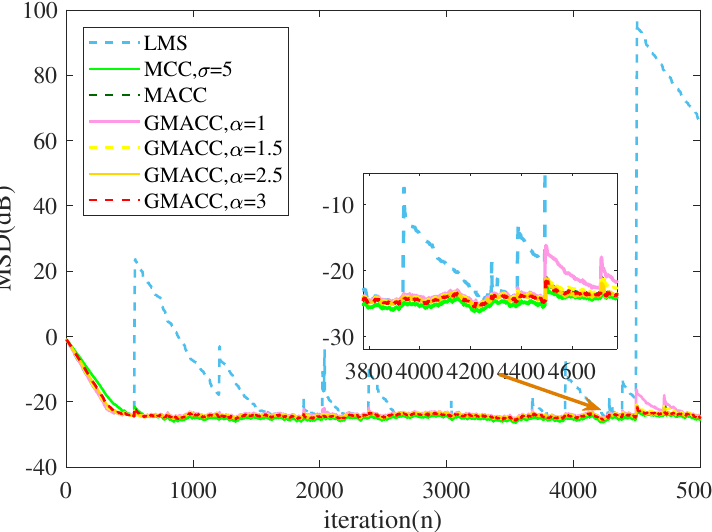
Figure 10. Steady-state performance comparison of different algorithms under the perturbation term of a symmetric non-Gaussian distribution close to a Gaussian distribution.